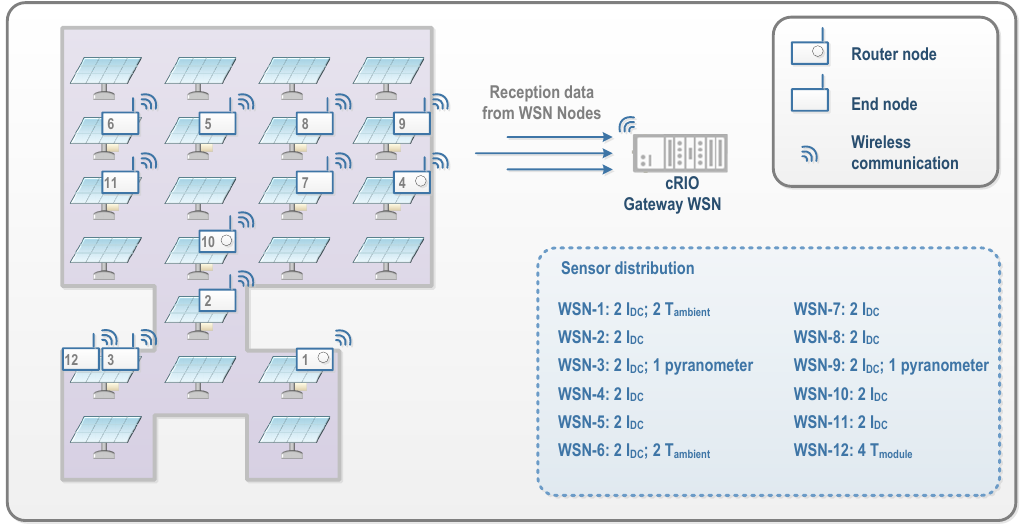
Figure 8. Relationship between the sensors and the wireless sensor network (WSN)